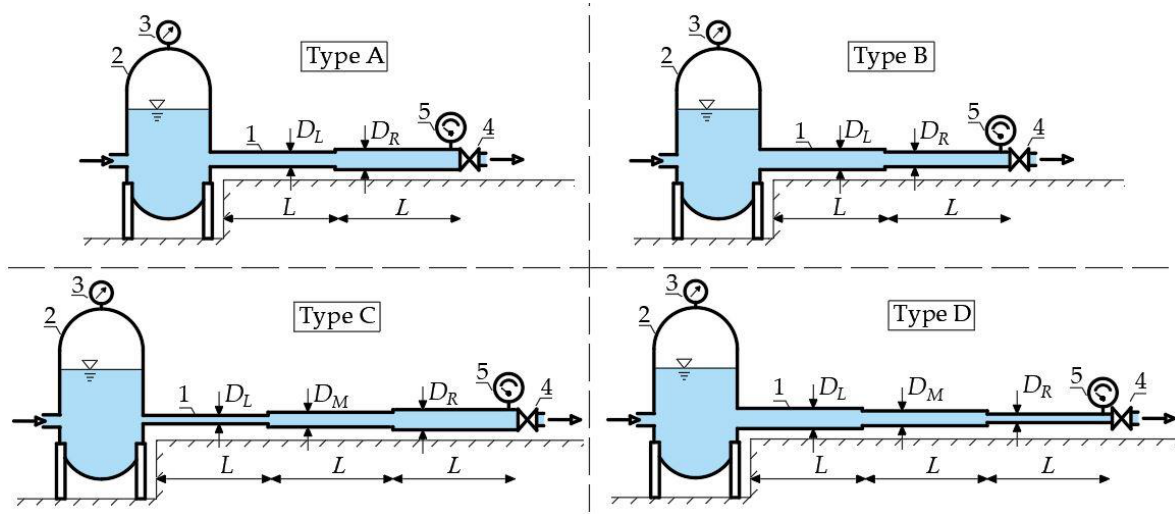
Figure 3. Experimental setup.